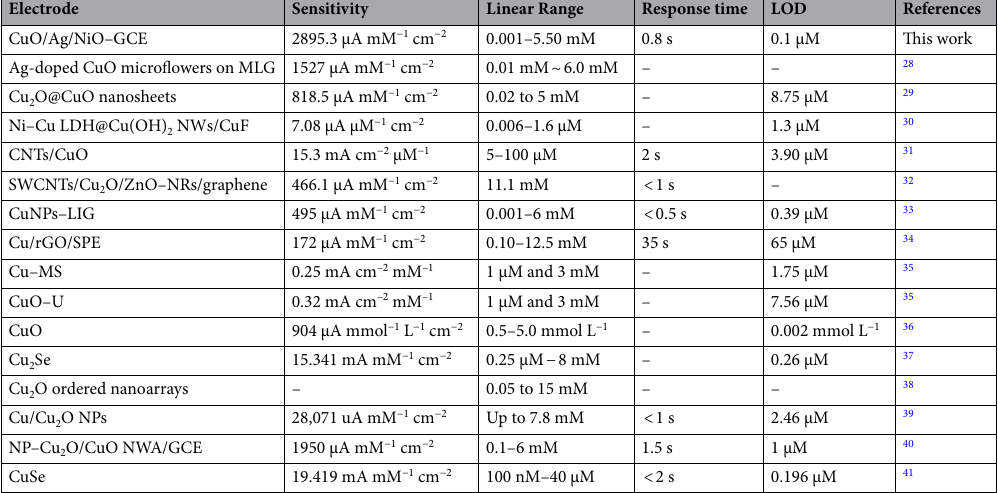
Table 1. Analytical performance comparison of non-enzymatic glucose sensor for diabetes